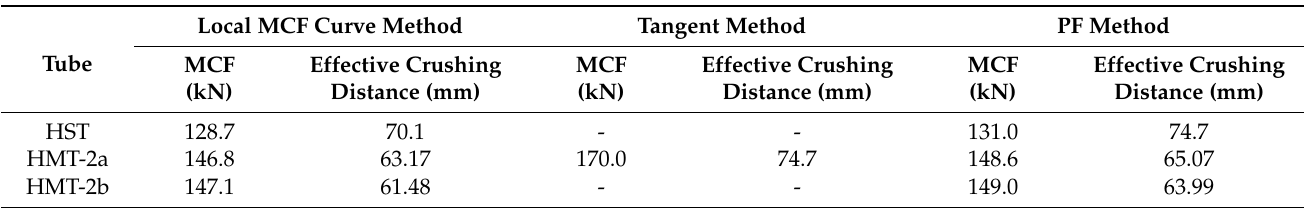
Table 4. Comparisons between three